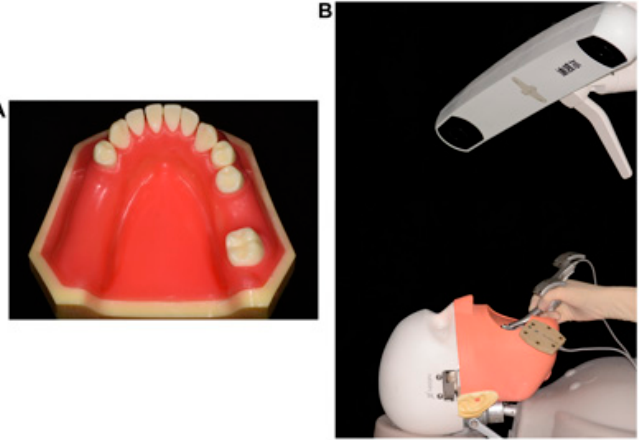
Figure 1. ( A ) Sample of the experimental model; ( B ) the plastic model was fixed onto a dental sim- ulation unit before implant placement under the guidance of the dynamic navigation system.